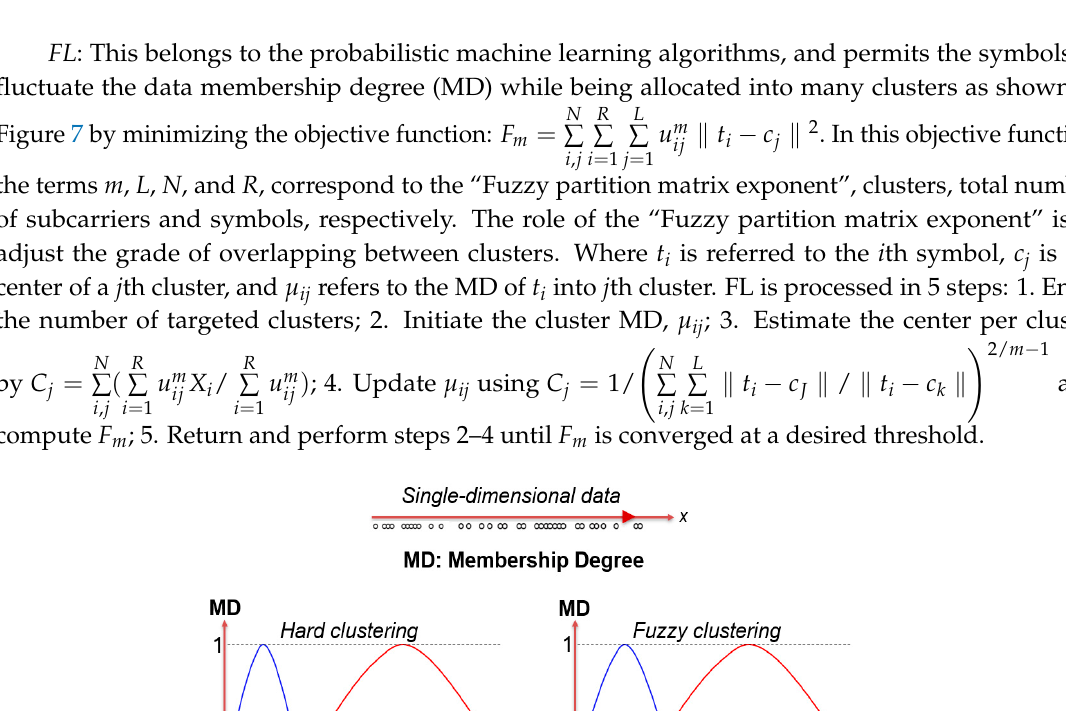
(cid:3404) ∑ (cid:3040)